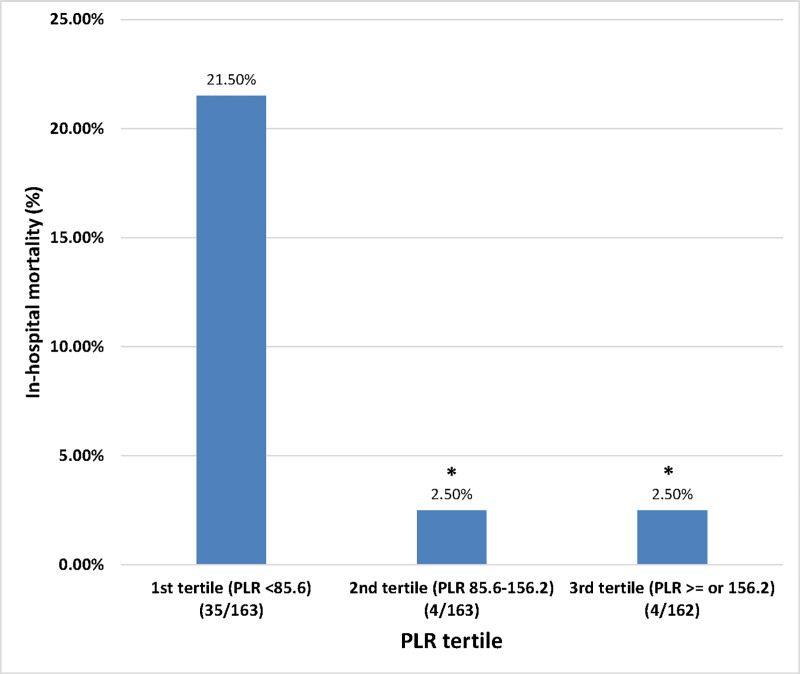
In-hospital mortality according to tertile of platelet-to-lymphocyte ratio (PLR).